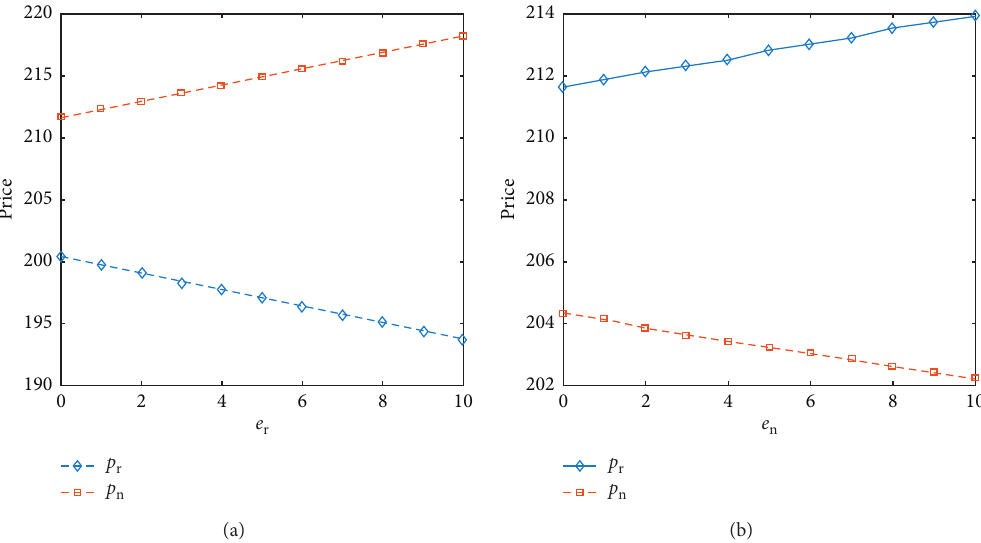
Figure 3: Impact of recycling effort e p and p ; (b) the influence of recycling effort e r n